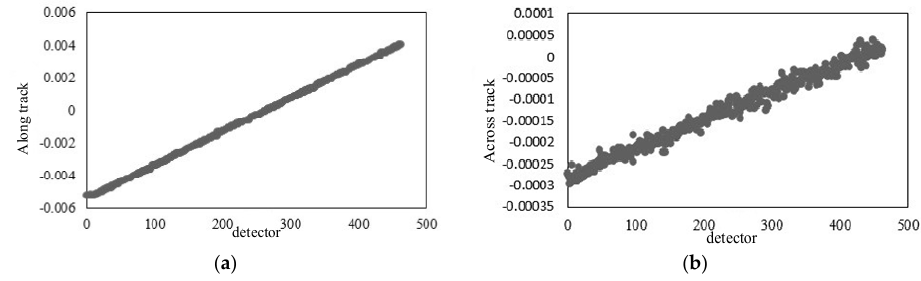
Figure 10. The diagram of detector look angle: ( a ) Along the track; ( b ) across the track. Figure 11 is the graph of the distribution of the residual errors after internal calibration. It can be seen from the contrast with Table 2 and Figures 8 and 9, that after internal calibration the interior orientation element error in the camera has also been eliminated. Additionally, either along the track or across the track, there is no obvious regularity for the residual error in the imaging geometric model globally. Besides this, the distribution of the residuals is uniform and the residual error is better than 1 pixel.